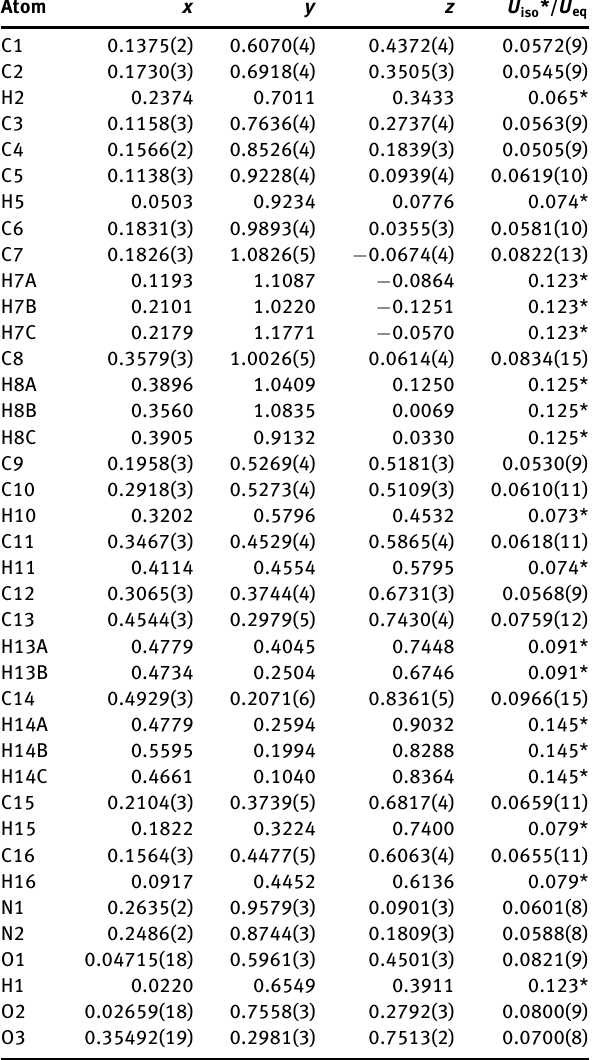
Table 2: Fractional atomic coordinates and isotropic or equivalent isotropic displacement parameters (Å 2